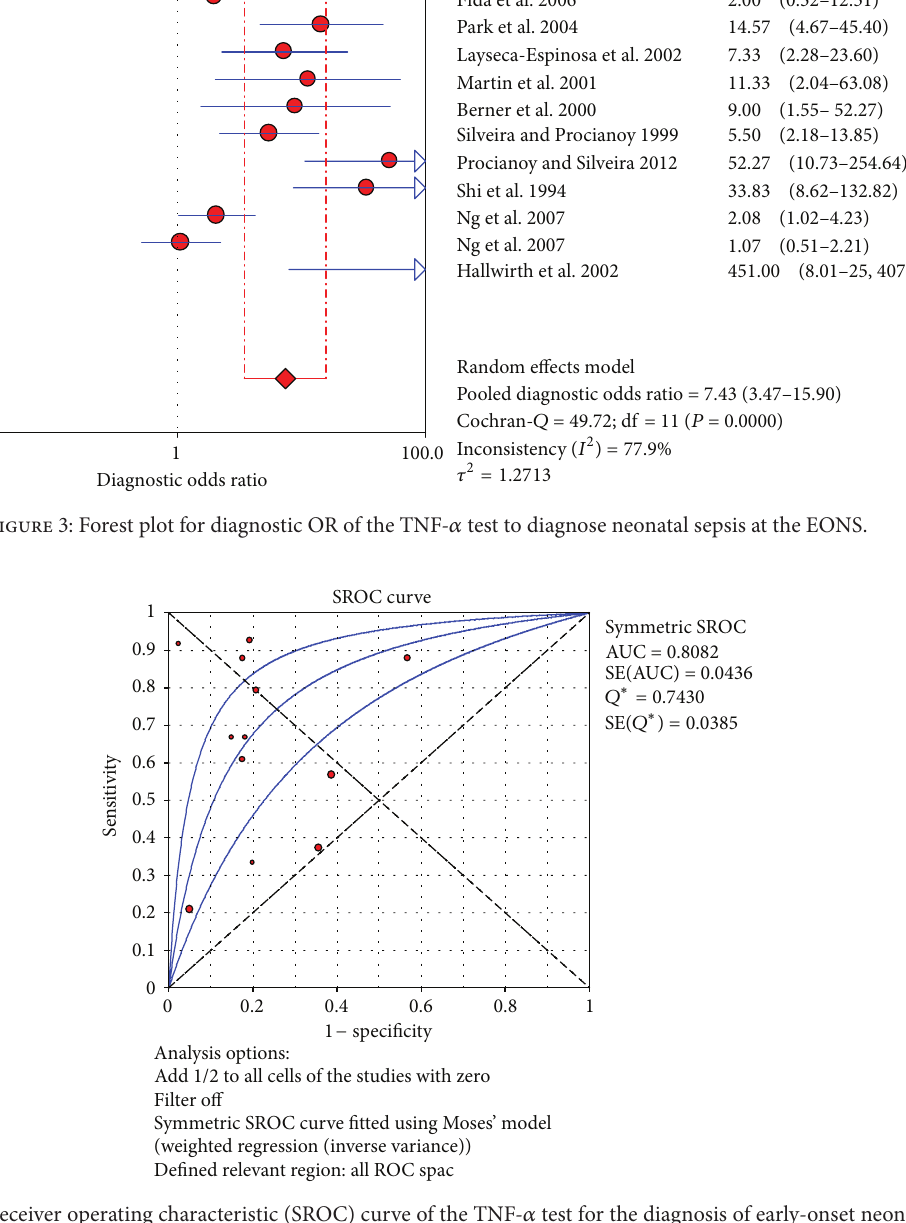
Figure 4: Summary receiver operating characteristic (SROC) curve of the TNF- 𝛼 test for the diagnosis of early-onset neonatal sepsis. Each point represents one study in the SROC